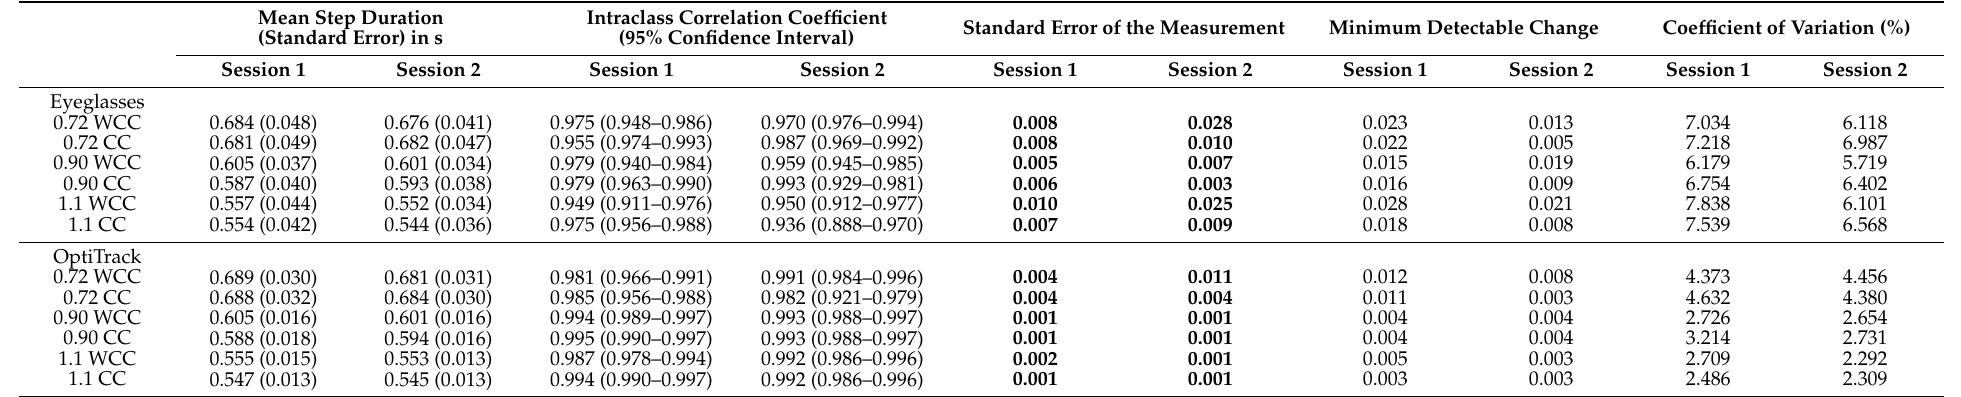
Table 1. Mean step duration values, intraclass correlation coefficient (95% confidence interval), standard error of the measurement, minimum detectable change and coefficient of variation (%) measured with the optoelectronic system (OptiTrack) and the eyeglasses during 30 s of gait for both sessions. Mean Step Duration (Standard Error) in s